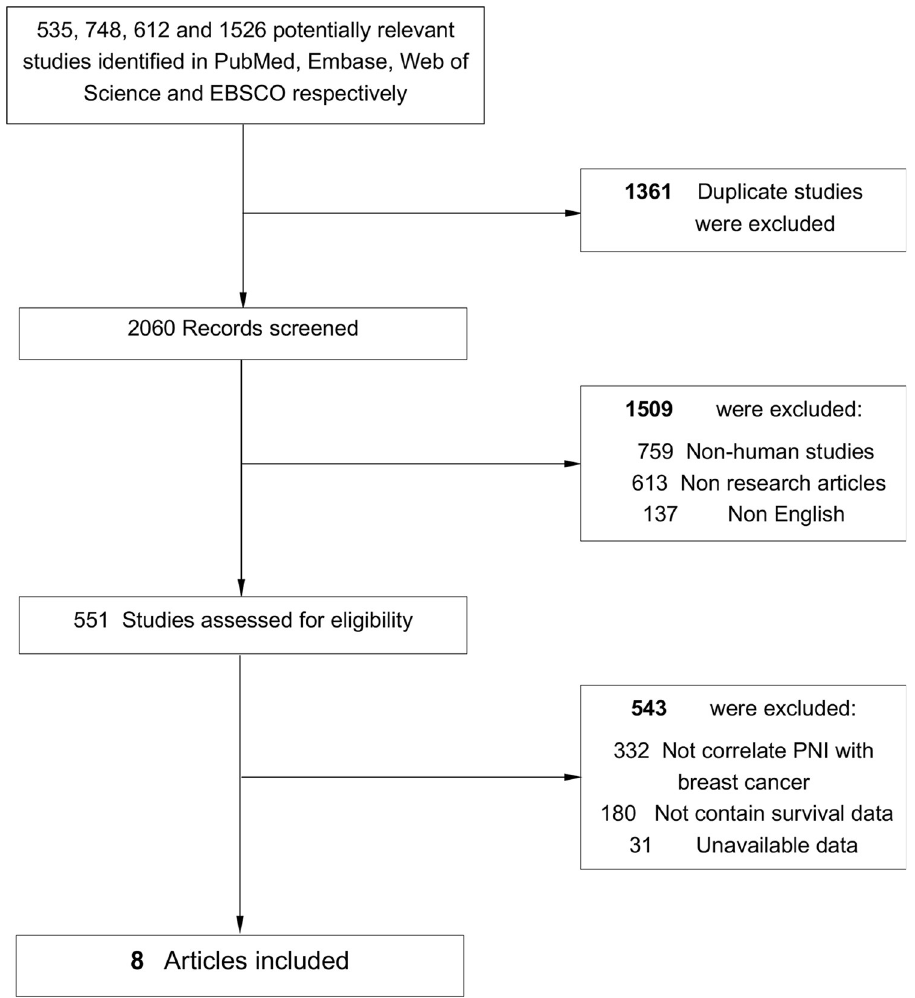
Fig 1. Flow chart diagram of study